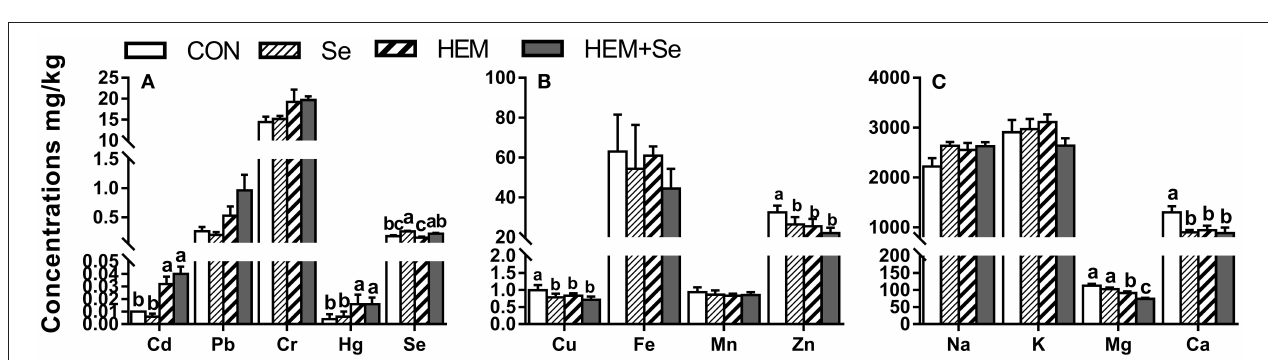
correlated with Fe ( p < 0.05). Mn was positively correlated